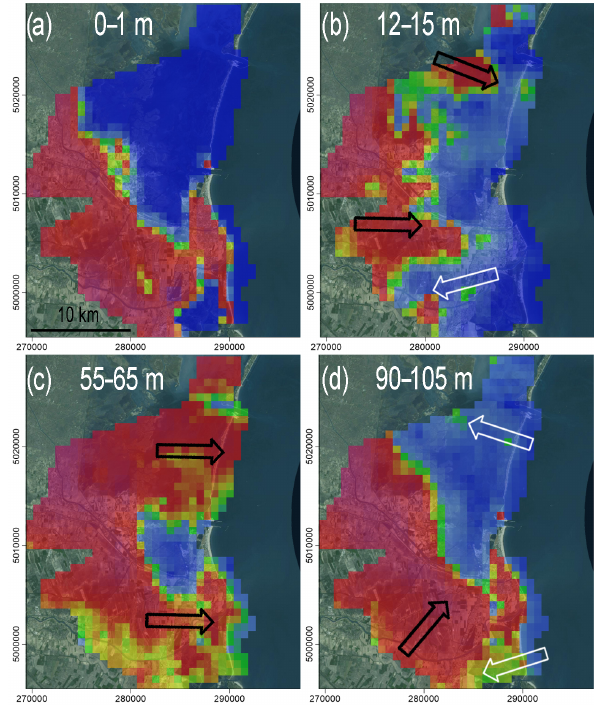
Figure 3. Conceptualization of the freshwater-saltwater relation- ship at different depths, obtained by integrating the results of the AEM survey with previous available information: (a) 0–1m, (b) 12–15m, (c) 55–63m, (d) 91–108m. Fresh-, brackish- and salt- waters are represented by red, green/yellow and blue colors, respec- tively. White and black arrows delineate the advancement of the saltwater intrusion and freshwater flow,